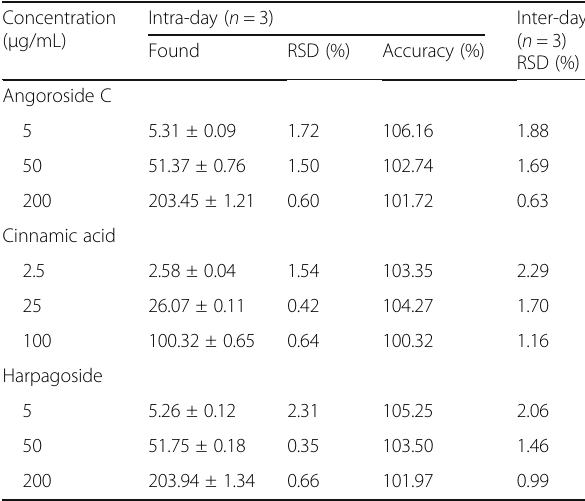
Table 1 Precisions of angoroside C, cinnamic acid and harpagoside